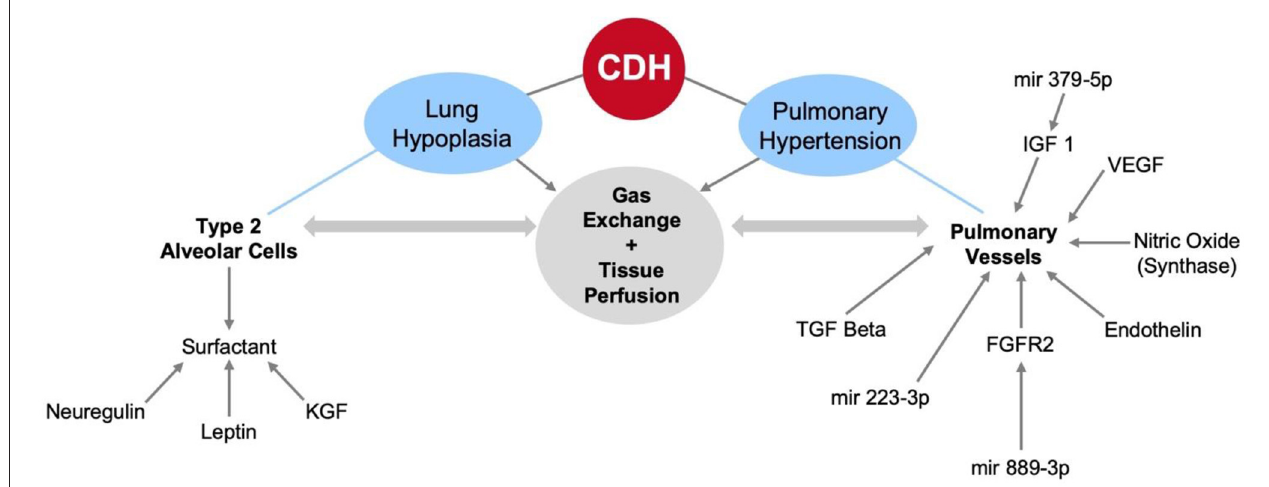
FIGURE 4 | The cellular and molecular factors affecting pulmonary changes in fetoscopic endoluminal tracheal occlusion for CDH patients.